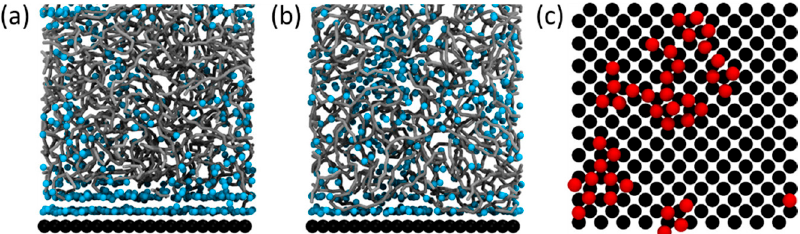
Figure 4. Snapshots of molecular dynamic simulations depicting solvated polymers (in gray) near a silica surface (in dark). Panels ( a ) and ( b ) refer to PAAm and PDMAm, respectively. Panel ( c ) shows the top view of the absorbed PDMAm monomers. Reprinted with permission from Perrin, E.; Schoen, M.; Coudert, F.; Boutin, A. Structure and Dynamics of Solvated Polymers near a Silica Surface: On the Different Roles Played by Solvent Journal of Physical Chemistry B 2018 , 122, 4573–4582. Copyright (2018)